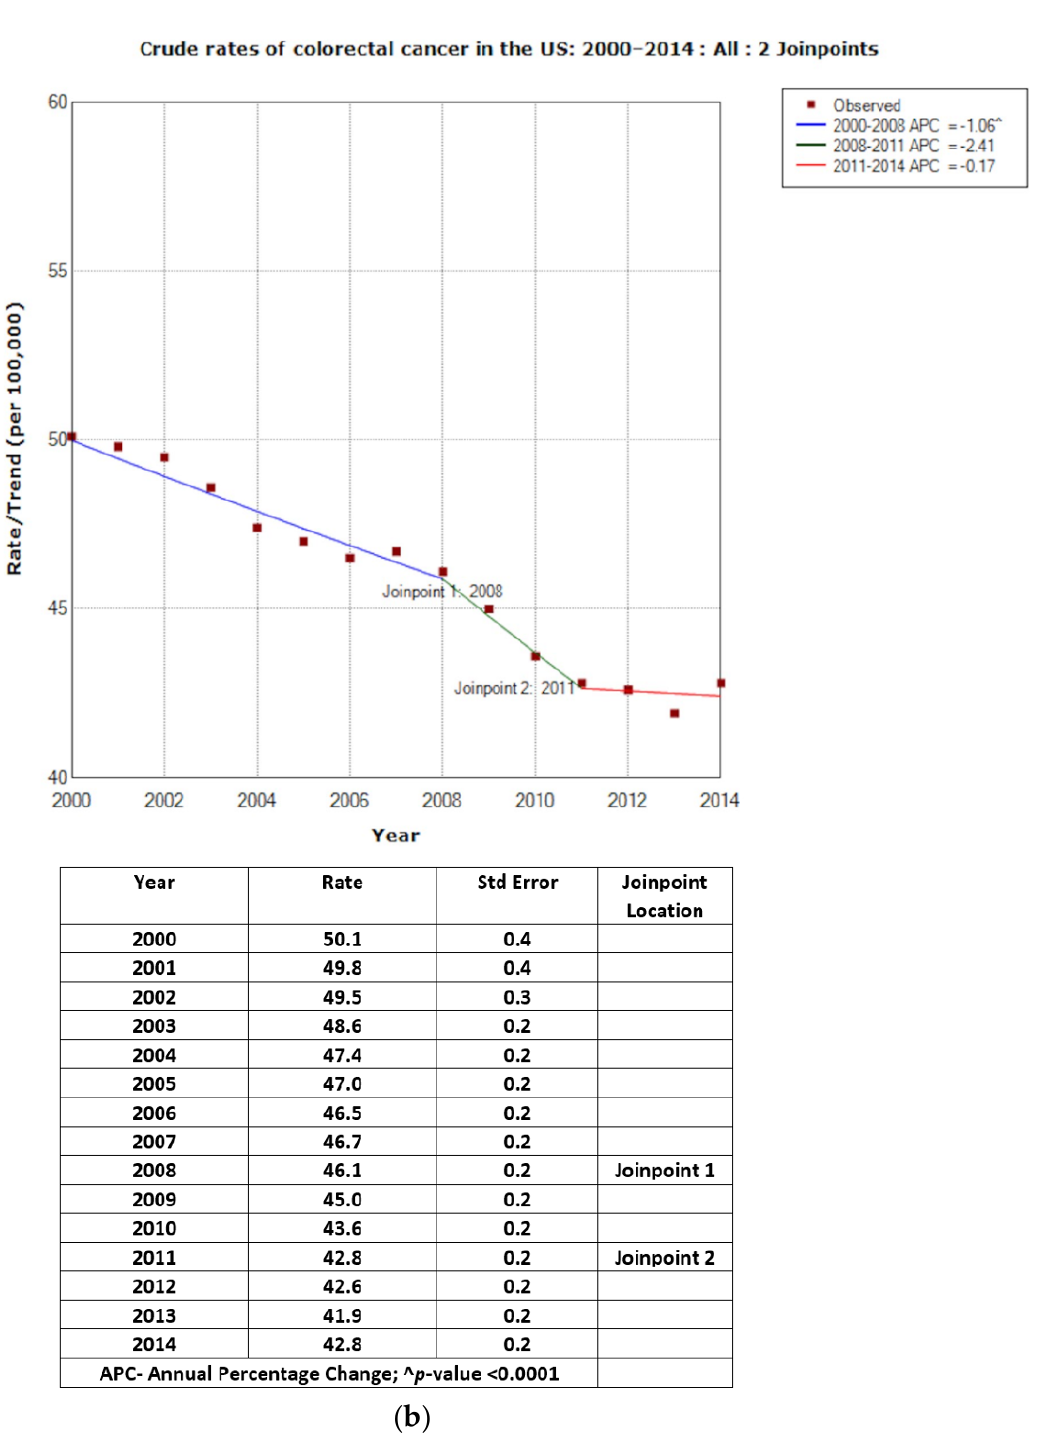
Figure 2. ( a ) Crude rates of colorectal cancer in the USA: 2000–2014: All: 0 Joinpoints. ( b ) Crude rates of colorectal cancer in the USA: 2000–2014: All: 2 Joinpoints.